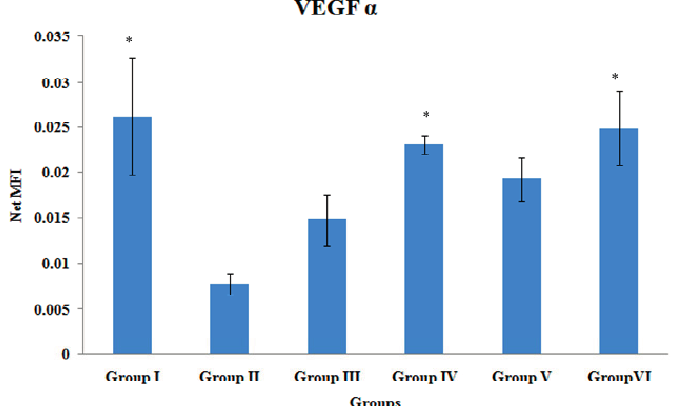
Figure 3. VEGF- α Gene Expression. Samples were normalized to GAPDH MFI (Median Fluorescence Intensity). Values were expressed as mean ± SEM. Group I: sham-operated group, ovariectomized+Tocotrienol+Lovastatin. * Indicates a significant difference ( p < 0.05) compared with the group II.